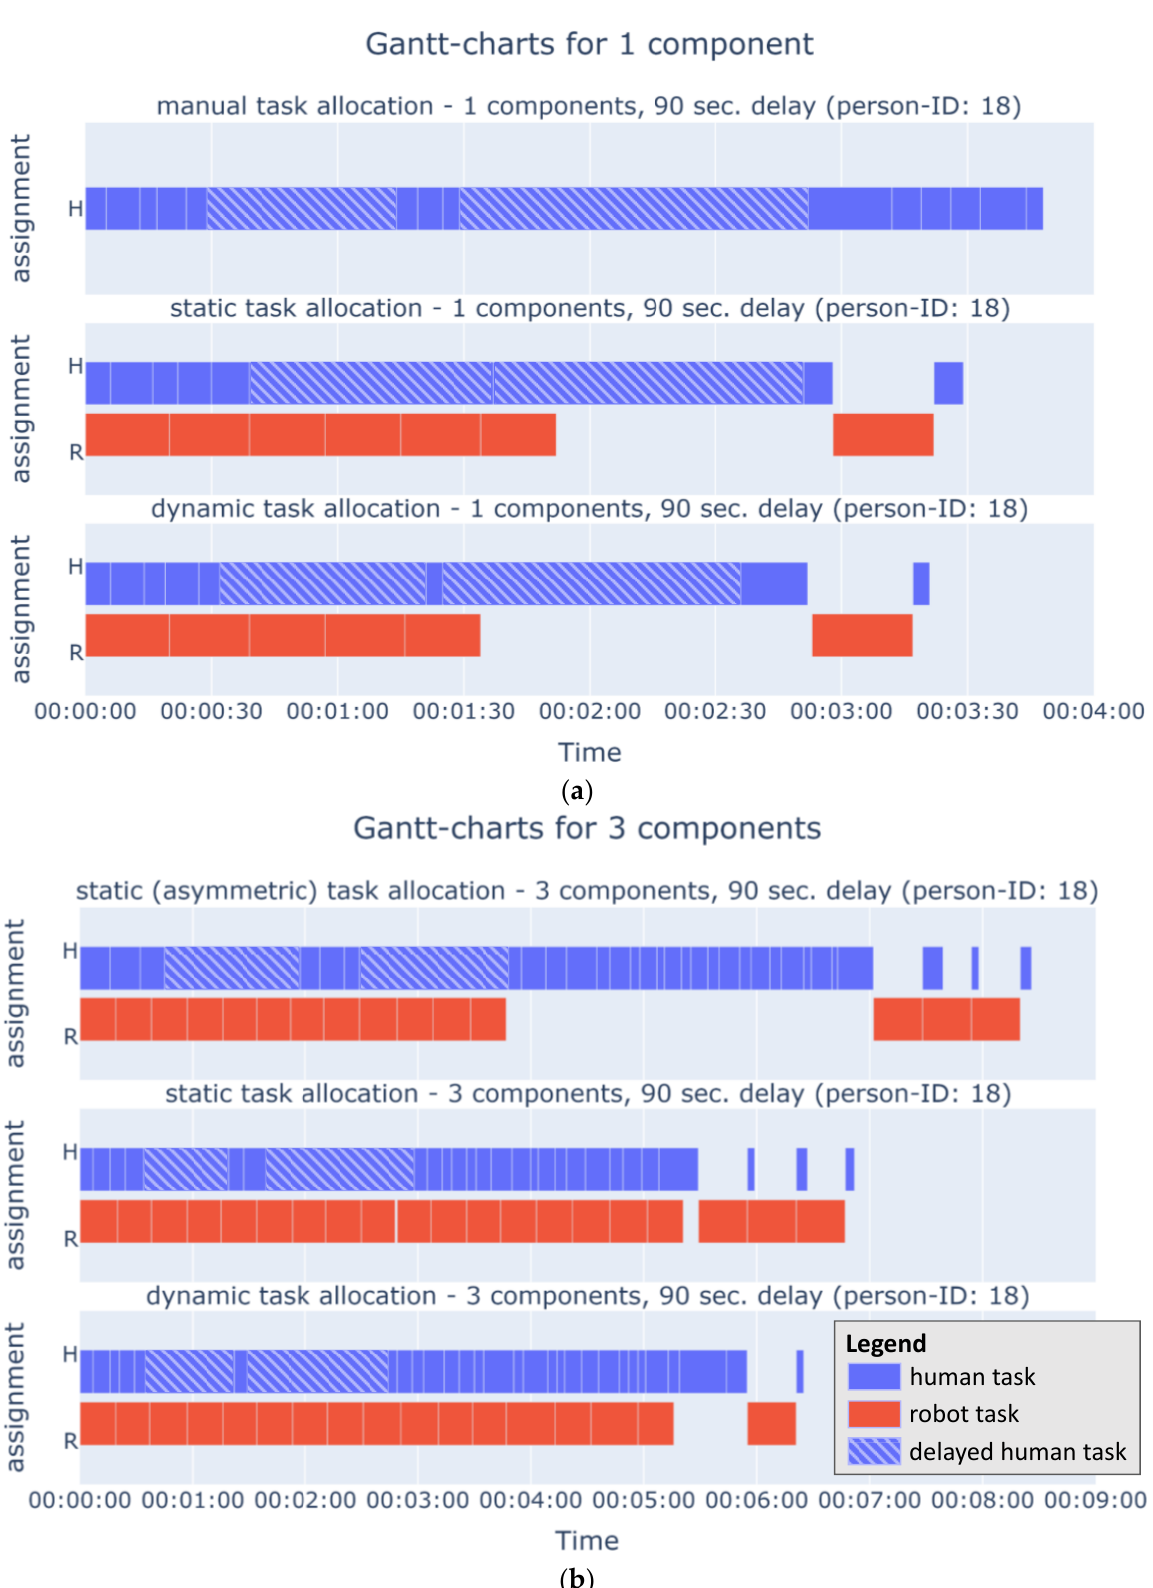
Figure 17. Exemplary Gantt charts for assembly process in different task allocation modes: ( a ) assembly of one component with 90 s human delay; ( b ) assembly of three components with 90 s human delay.